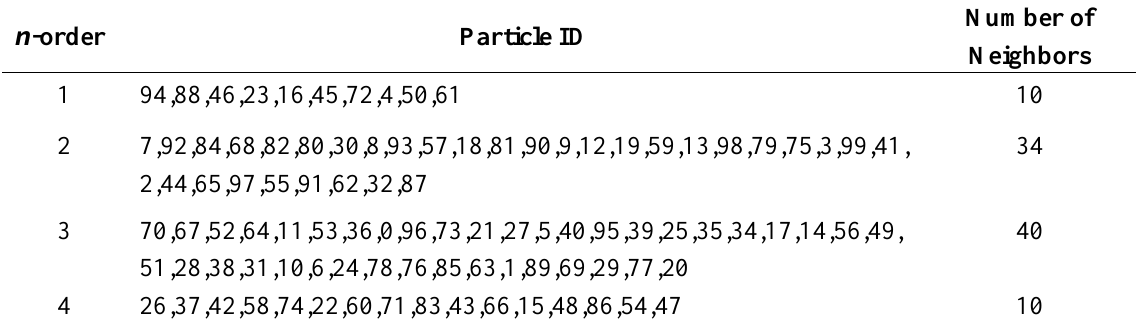
Figure 3. 4 -order neighbors in the 3D Voronoi diagram of 100 particles ( a ) with the highlighted one at the corner ( b ) and a slicing profile crossing the highlighted one to show the gradual neighbor relationships in 2D ( c ). Table 2. N-order neighbors of a certain particle in a 3D Voronoi